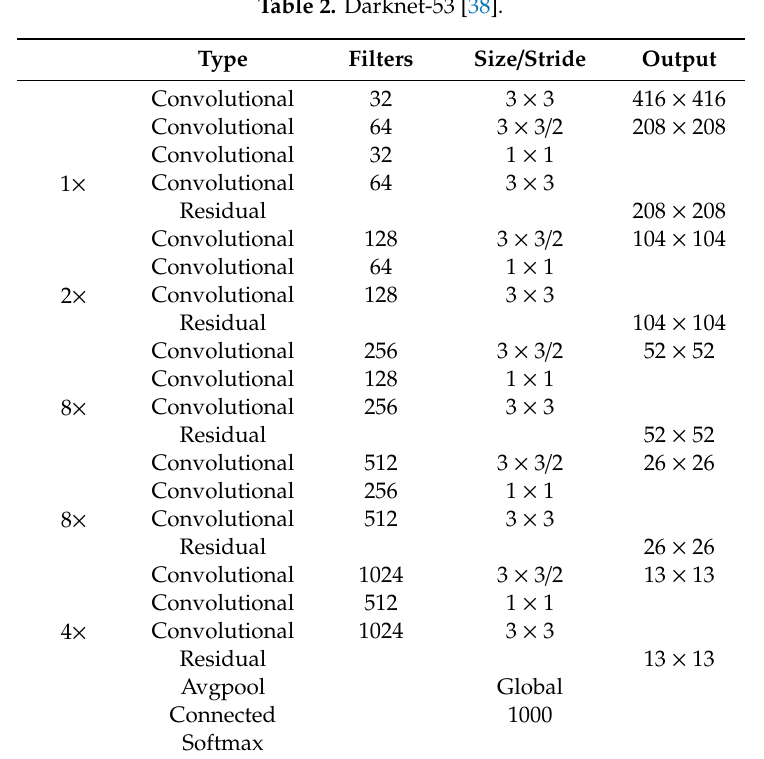
Figure 4. YOLOv3 network structure. Table 2. Darknet-53